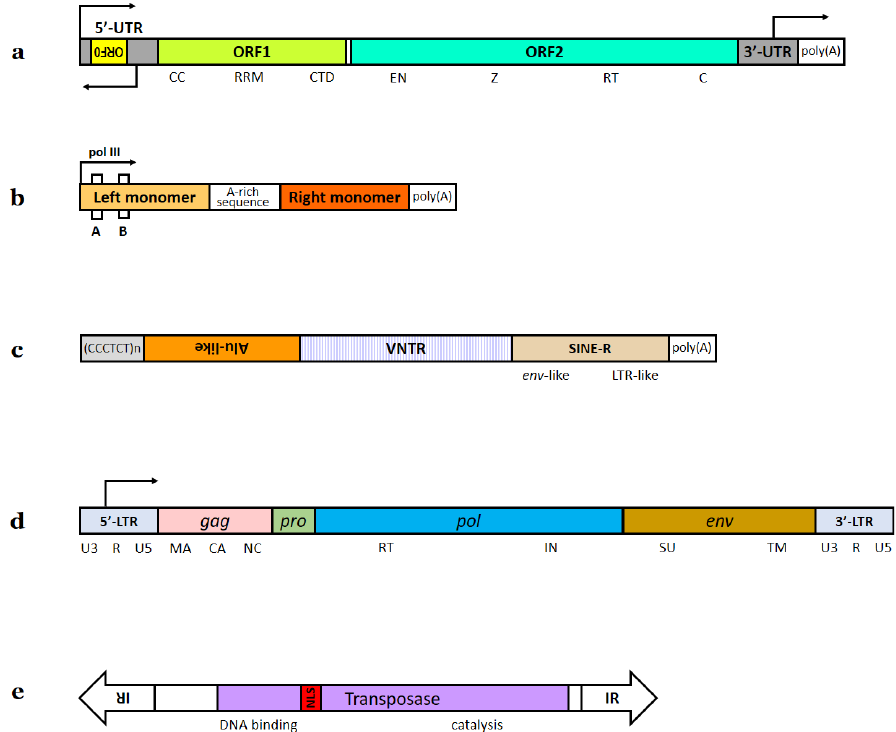
Figure 1. Types of human transposons. ( a ). L1 element. Two ORFs of human L1 are separated by a non-coding spacer region containing a stop codon [48]. The L1 5 (cid:48) -UTR has promoter activity in both sense and antisense directions. A small primate-specific antisense ORF0 was identified within L1 5 (cid:48) -UTR downstream of the antisense promoter [49]. An additional sense promoter was identified in 3 (cid:48) -UTR [46]. ORF1 encodes a protein that contains a coiled–coil domain (CC), a non-canonical RNA recognition motif domain (RRM) and a basic C -terminal domain (CTD). ORF2 encodes a protein that has endonuclease (EN) and reverse transcriptase (RT) activities. Functions of the Z domain and the cysteine-rich motif (C) are unknown [101]. ( b ). Alu element. These elements contain two monomeric sequences derived from 7SL RNA and end in an A-rich tail. The left monomer contains an internal pol III promoter and is separated from the right monomer by an adenosine-rich sequence [34]. Alu pol III promoter elements (Box A and Box B) may only provide efficient transcription if an upstream pol III enhancer is present at the site of integration [93]. ( c ). SVA element. These elements include CCCTCT hexameric repeats, the Alu-like domain consisting of two antisense Alu fragments separated by a unique sequence, a GC-rich VNTR domain consisting of tandem repeats, and the SINE-R domain sharing homology to the 3 (cid:48) end of the HERV-K10 element (a fragment of its env gene and right LTR) [103]. ( d ). ERV. The order of the structural genes and the arrangement of their major cleavage products are completely conserved among all retroviruses and are necessary for correct virion assembly. Domains within Gag protein: matrix (MA), capsid (CA), nucleocapsid (NC). Domains within Pol protein: reverse transcriptase (RT), integrase (IN). Domains within Env protein: surface protein (SU), transmembrane protein (TM). Env is translated from a spliced subgenomic RNA and is then cleaved to generate SU and TM subunits. Each of the LTRs is composed of the unique U3 and U5 regions separated by a segment (R) repeated at each end of the viral RNA. U3 contains TF binding sites. Transcription from the provirus starts at the left U3-R junction, and the right R-U5 junction provides the site of 3 (cid:48) -polyadenylation. The left U3 and the right U5 are restored during dsDNA formation in the virus replication cycle [25]. ( e ). DNA transposon (Tc1/ mariner family). The terminal inverted repeats (IR) contain binding sites for the transposase. The N -terminal part of the transposase contains a DNA binding domain. The C -terminal part of the protein performs target DNA site cleavage and transposon integration. NLS—nuclear localization signal [110]. The elements in this figure are not drawn to